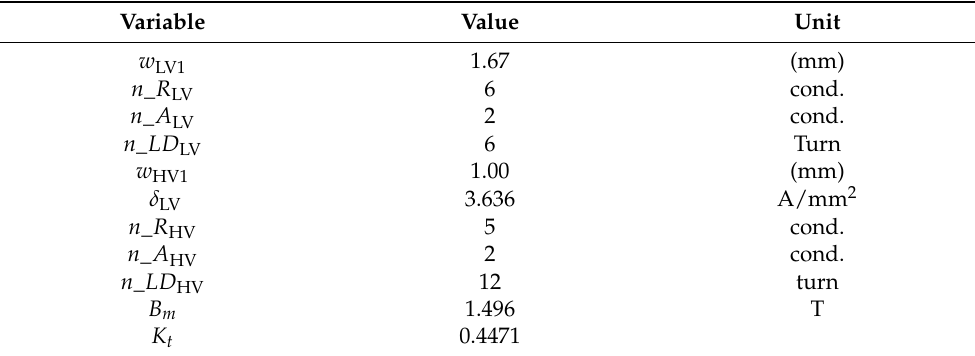
Table 4. The result of optimized